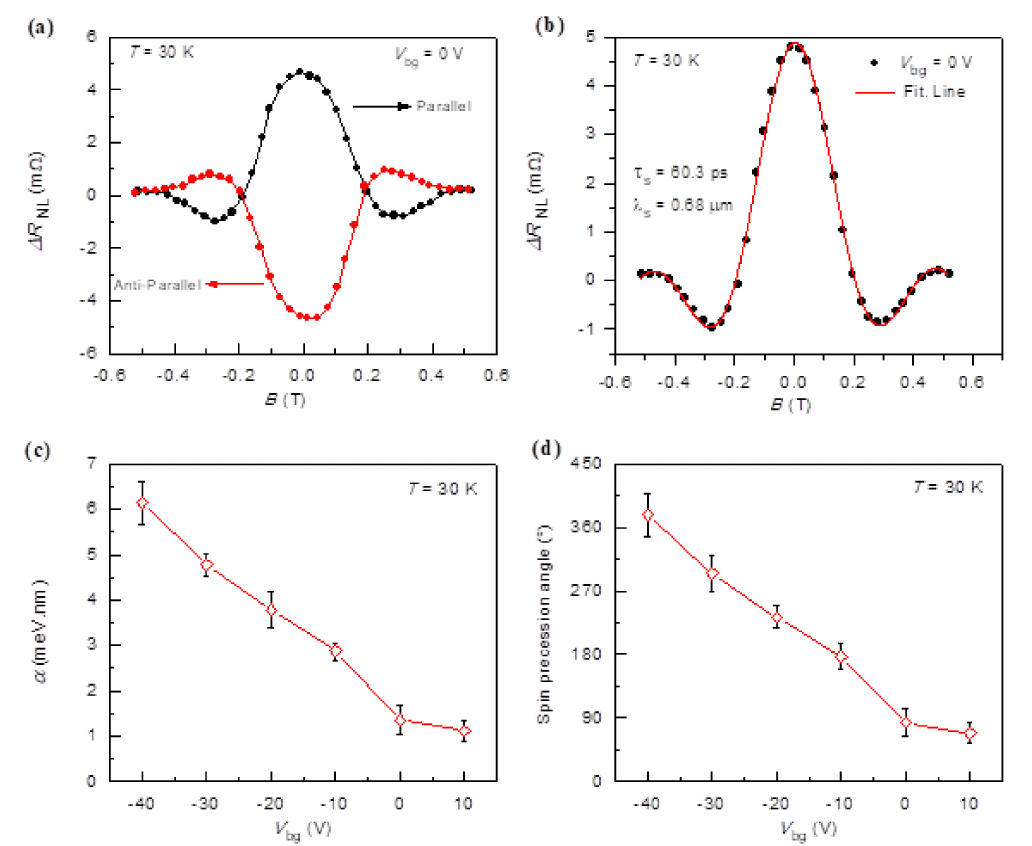
Figure 3. ( a ) Modulation of Hanle spin precession with V bg . Hanle spin signal measured at different V bg at 30 K. ( b ) The NL − R Anti − parallel Hanle spin signal ( ∆ R NL = R Parallel /2 ) at V bg = 0 V is fitted to Equation (3) for τ s and λ s . ( c ) Gate voltage NL NL dependence of the SOI parameter ( α ). ( d ) Estimated spin precession angle as a function of V bg at 30